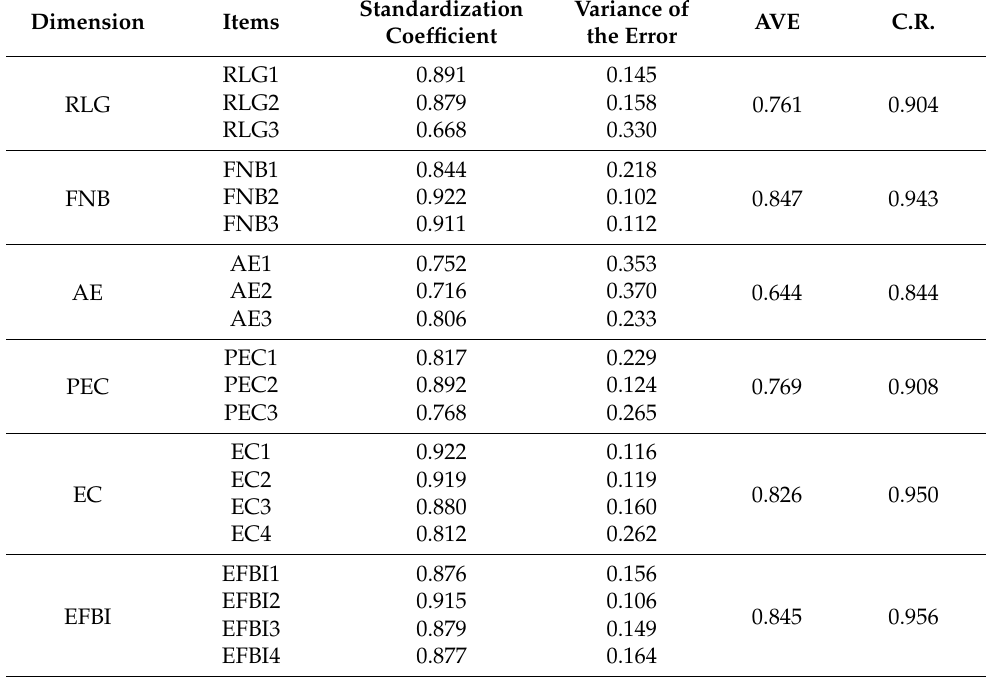
Table 3. Results of confirmatory factor